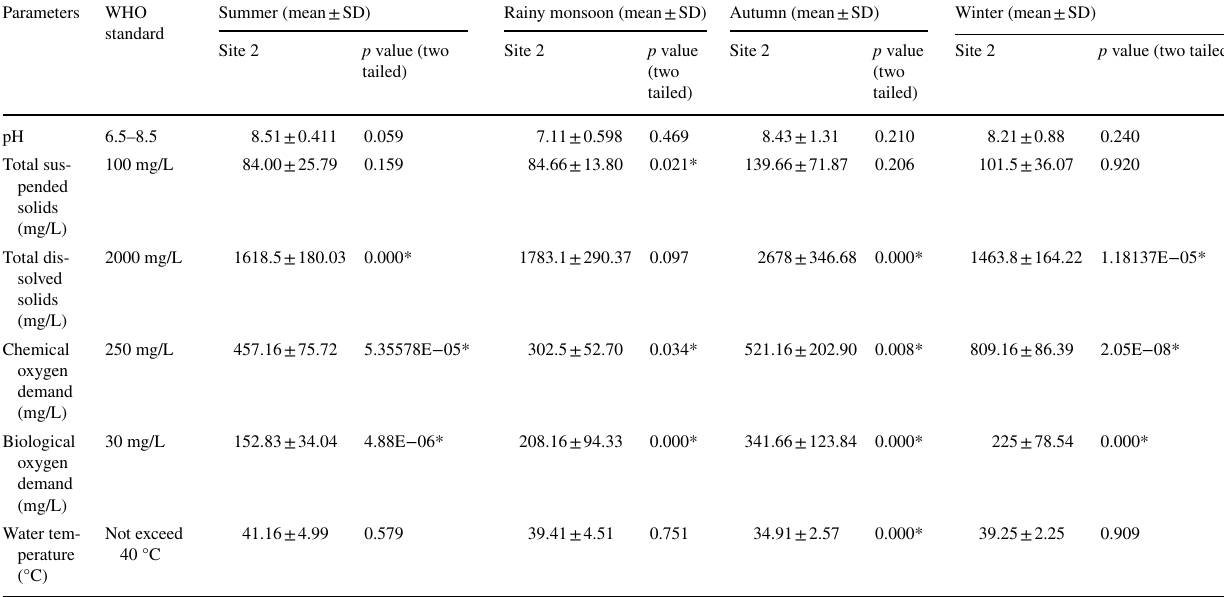
* p < 0.05 (highly significant) Table 3 Seasonal fluctuations in physicochemical parameters at Site 2 from June 2014 to May 2015